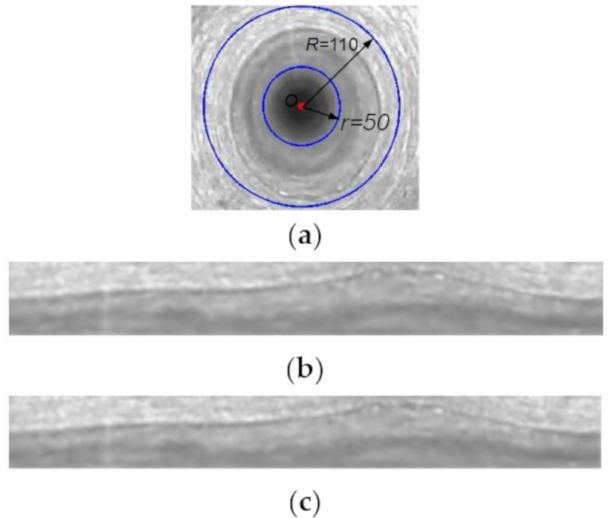
Figure 15. Borehole unfolded images. ( a ) Front view borehole-wall image; ( b ) unfolded image obtained by the bilinear interpolation and ( c ) unfolded image obtained by the cubic convolution